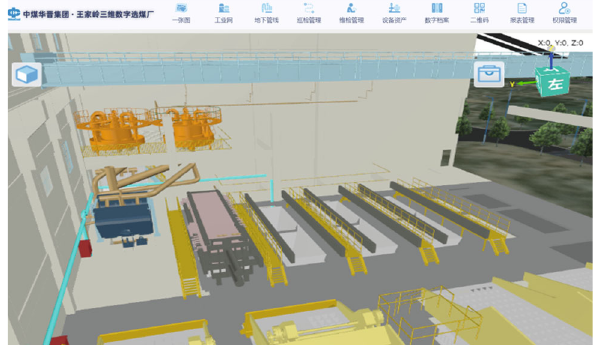
Figure 6: BIM-based 3D visualization platform of Wangjialing Coal Preparation Plant.